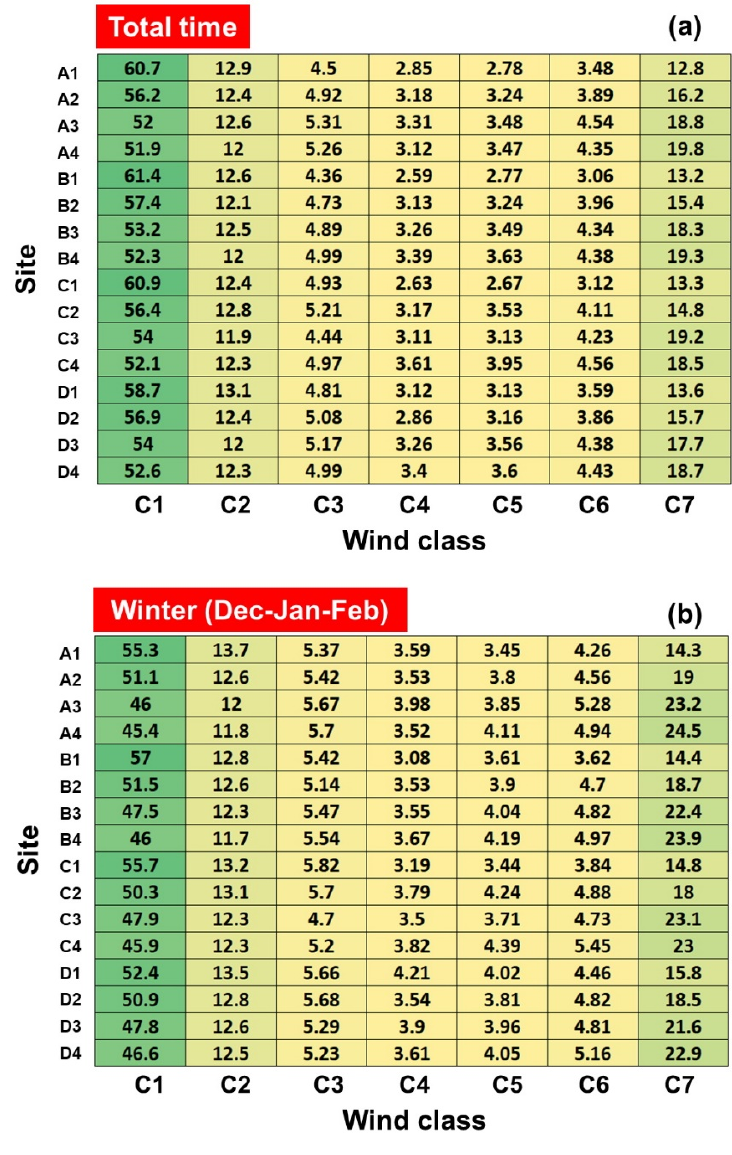
Figure 5. Distribution of the U 100 parameter by wind classes (January 1979 to December 2020), where: ( a ) Total time values; ( b ) winter values. Table 4. Wind classification at 100 m, processed from Oh et al.